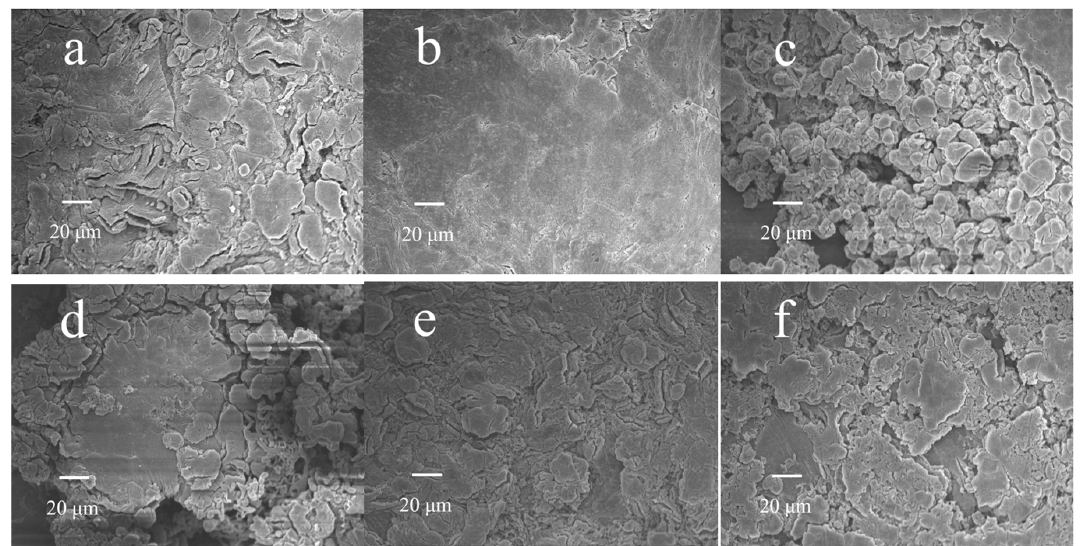
Figure 7. SEM images of cycled Li foil assembled with different cathodes prepared with ( a ) PVDF, ( b ) γ -PGA, ( c ) PVP, ( d ) CMC, ( e ) PAN, and ( f ) PEO. ( b ) γ -PGA, ( c ) PVP, ( d ) CMC, ( e ) PAN, and ( f )